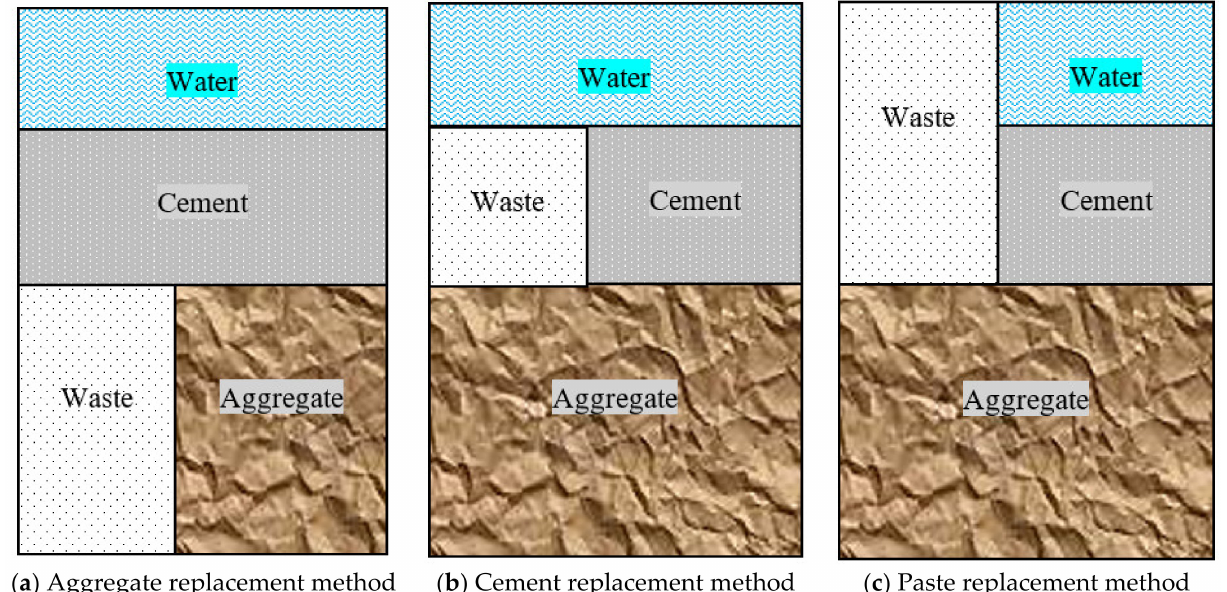
Figure 1. Schematic diagram of replacement